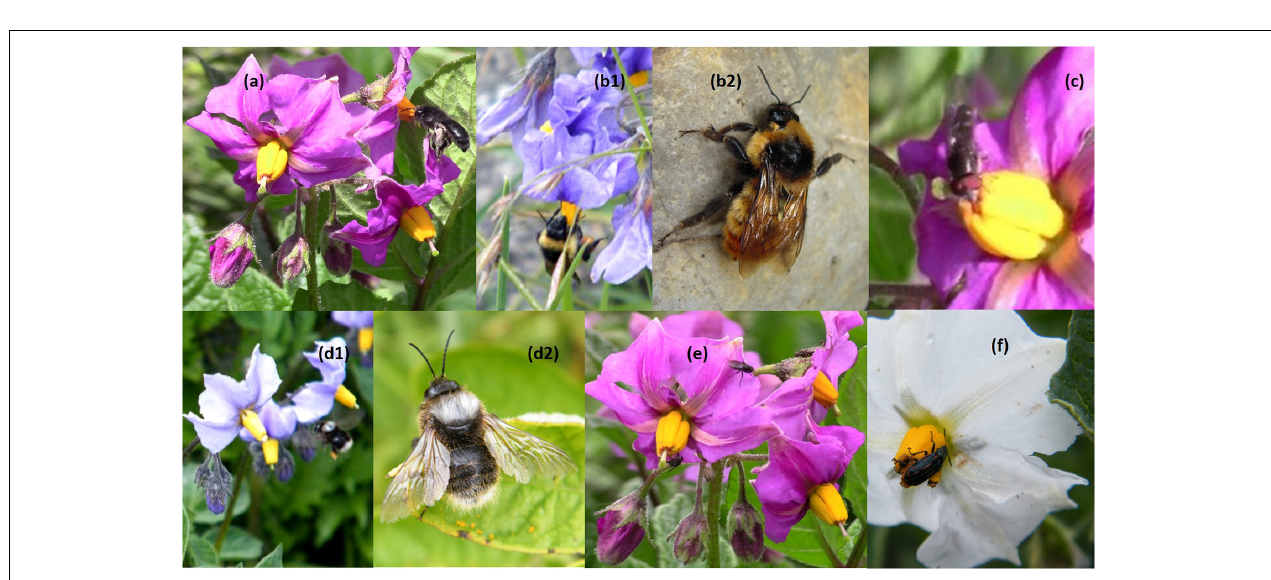
Frontiers in Ecology and Evolution |